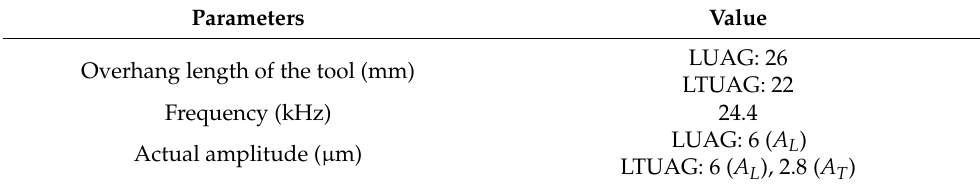
Table 3. Ultrasonic vibration parameters of LUAG and